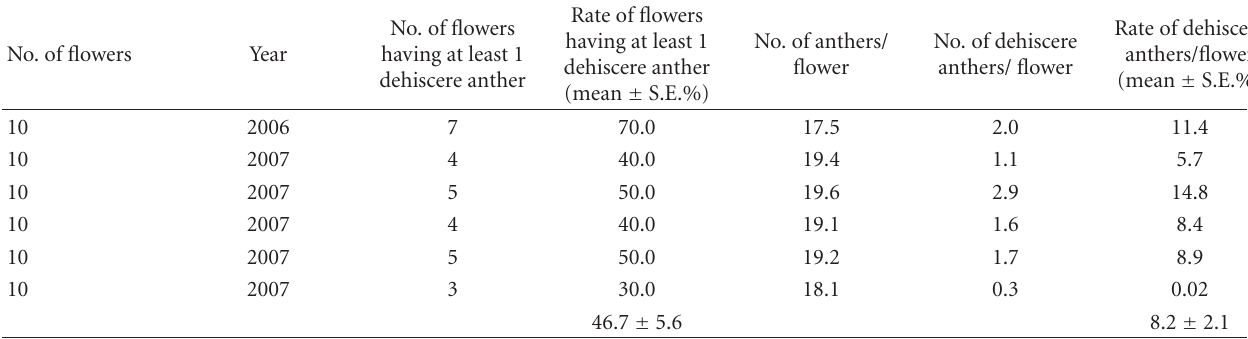
Table 2: Rate of dehiscere anthers within a balloon-stage “Maypole”.